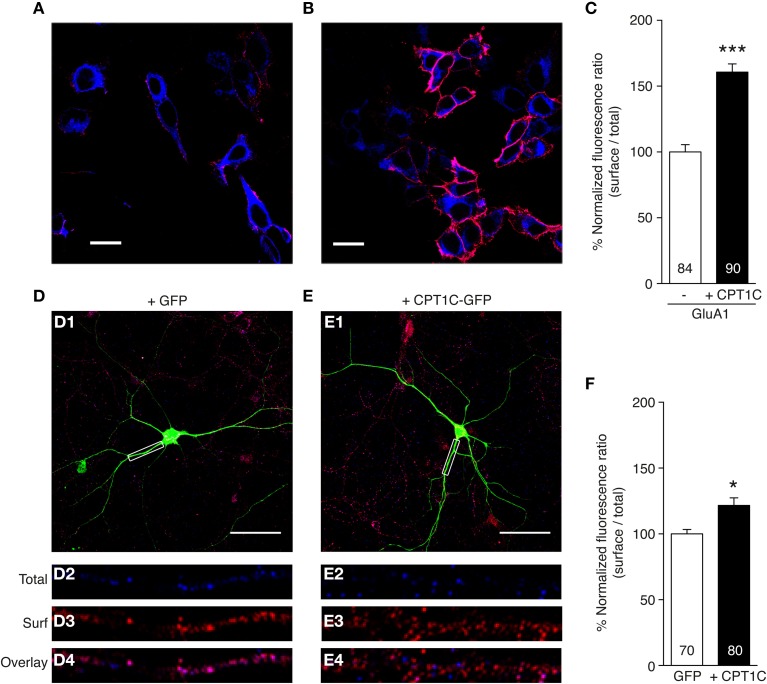
CPT1C enhances surface expression of GluA1. (A,B) Representative single confocal images of tsA201 cells co-expressing GluA1 and GFP (A) or GluA1 and CPT1C-GFP (B). Surface GluA1 was labeled in live cells with anti-GluA1-NT and Alexafluor 555 (red signal in the images). Subsequently cells were permeabilized and total GluA1 expression level was labeled with the same primary antibody but with Alexafluor 647 (blue signal in the images). Scale bars: 20 μm. (C) Quantification of the GluA1 surface to total ratio normalized to GluA1, expressed as a percentage. GluA1 surface expression was increased by co-expression with CPT1C (***p < 0.001; Mann–Whitney U-test). Data are means ± SEM. Numbers in bars denote the number of cells quantified from 4 different immunofluorescence experiments. (D) Example of a DIV 10 cortical neuron transfected with GFP. Surface GluA1 was labeled in fixed cells with anti-GluA1-NT and Alexafluor 555 (red signal in the images). Subsequently cells were permeabilized and total GluA1 expression level was labeled with the same primary antibody but with Alexafluor 647 (blue signal in the images). D1: field image showing the GFP in green, the surface GluA1 in red and the total GluA1 in blue. Scale bar: 50 μm. D2: magnification of the dendritic boxed area in D1 for total GluA1. D3: same as D2 but for surface GluA1. D4: overlay of intracellular and surface GluA1 for box in D1. (E) Example of a DIV 10 cortical neuron transfected with CPT1C-GFP in the same conditions as D. E1: field image showing the CPT1C-GFP in green, the surface GluA1 in red and the total GluA1 in blue. Scale bar: 50 μm. E2: magnification of the dendritic boxed area in E1 for total GluA1. E3: same as E2 but for surface GluA1. E4: overlay of total and surface GluA1 for box in E1. (F) Quantification of endogenous GluA1 surface to total ratio normalized to GFP transfected neurons, expressed as a percentage. GluA1 surface to total ratio was increased by overexpression of CPT1C-GFP (*p = 0.0226; Mann–Whitney U-test). Data represent means ± SEM. Numbers in bars denote the number of dendrites quantified from 3 different cultures.